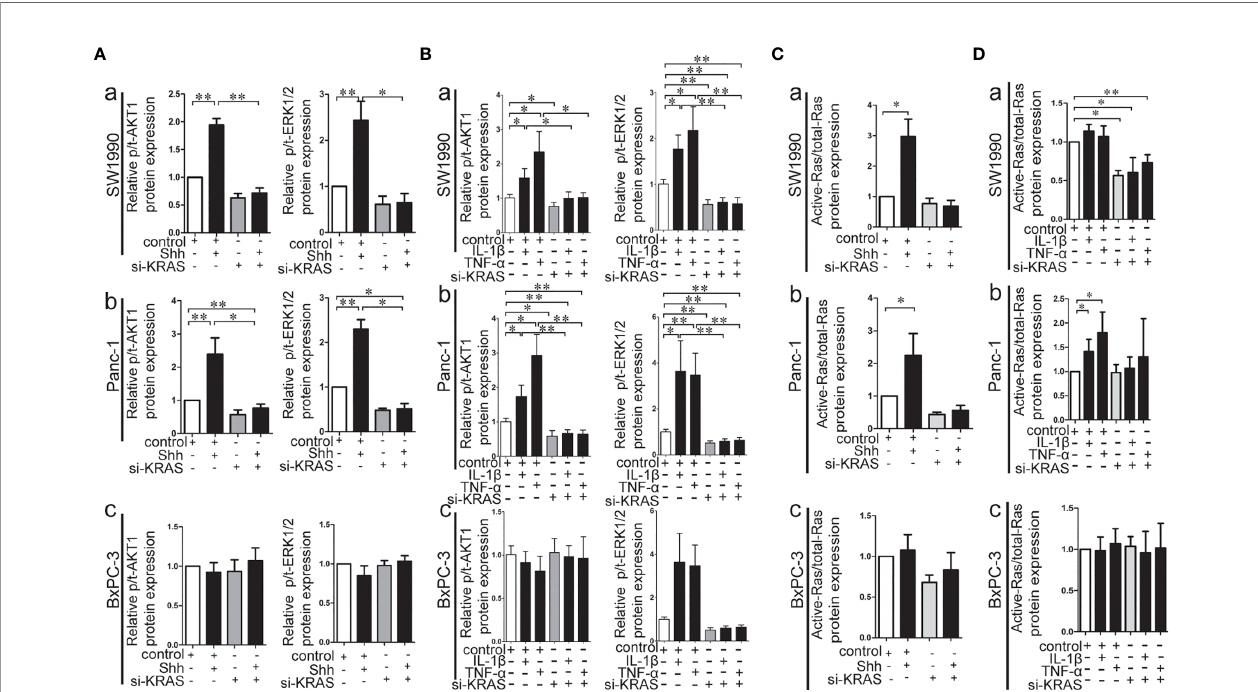
FIGURE 5 | The effect of IL-1 b , TNF- a , Shh treatment in combination with si-KRAS on KRAS down-stream molecules (p-/t-ERK1/2 and p-/t-AKT1) and Ras enzymatic activity in the MT-KRAS cell lines (SW1990 and Panc-1) and WT-KRAS cell line (BxPC-3). The protein expression of p-/t-ERK1/2 and p-/t-AKT1 at Shh treatment in combination with si-KRAS treatment (A) ; The effect of combined IL-1 b or TNF- a with si-KRAS transfection on p-/t-ERK1/2 and p-/t-AKT1 (B) ; Ras enzymatic activity at Shh treatment in combination with si-KRAS treatment (C) ; The effect of combined IL-1 b or TNF- a with si-KRAS transfection on Ras enzymatic